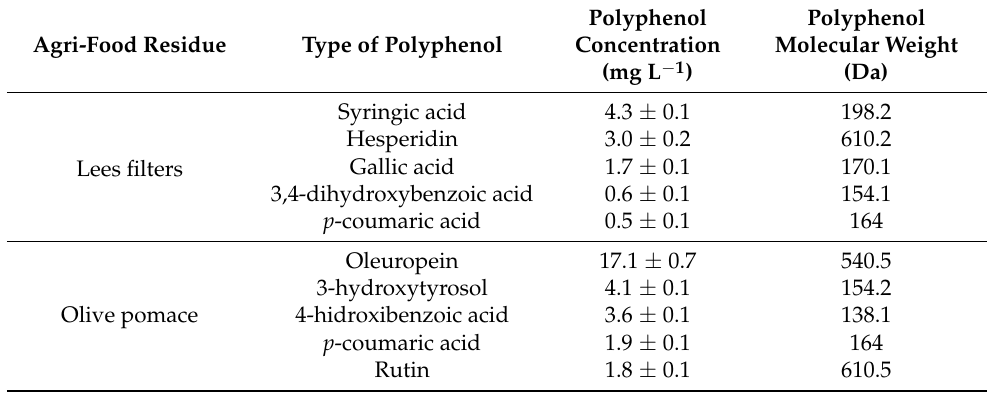
Table 2. Composition of polyphenols in the lees filters and olive pomace